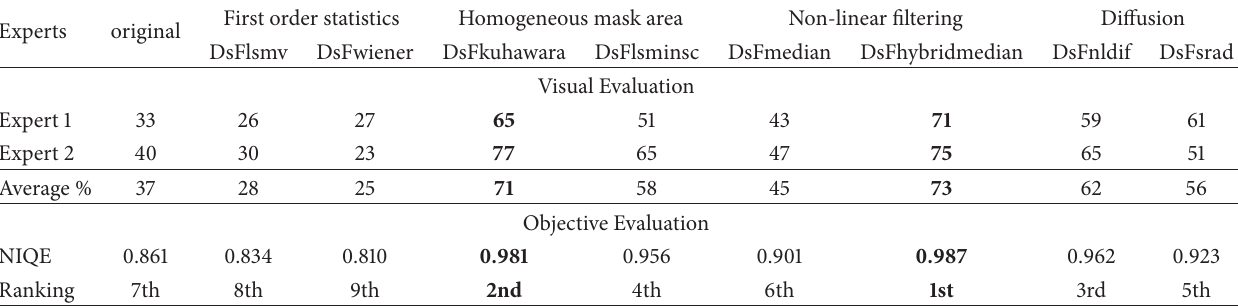
Table 2: Percentage scoring of visual and objective evaluation of the original and despeckled images by the experts and the natural image quality evaluation (NIQE) index. Bolded values show best performance.